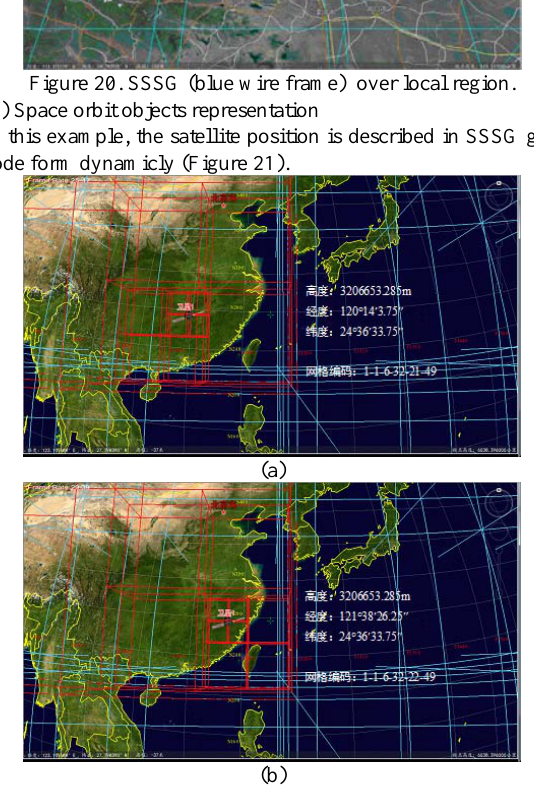
Figure 21. One moving satellite in the